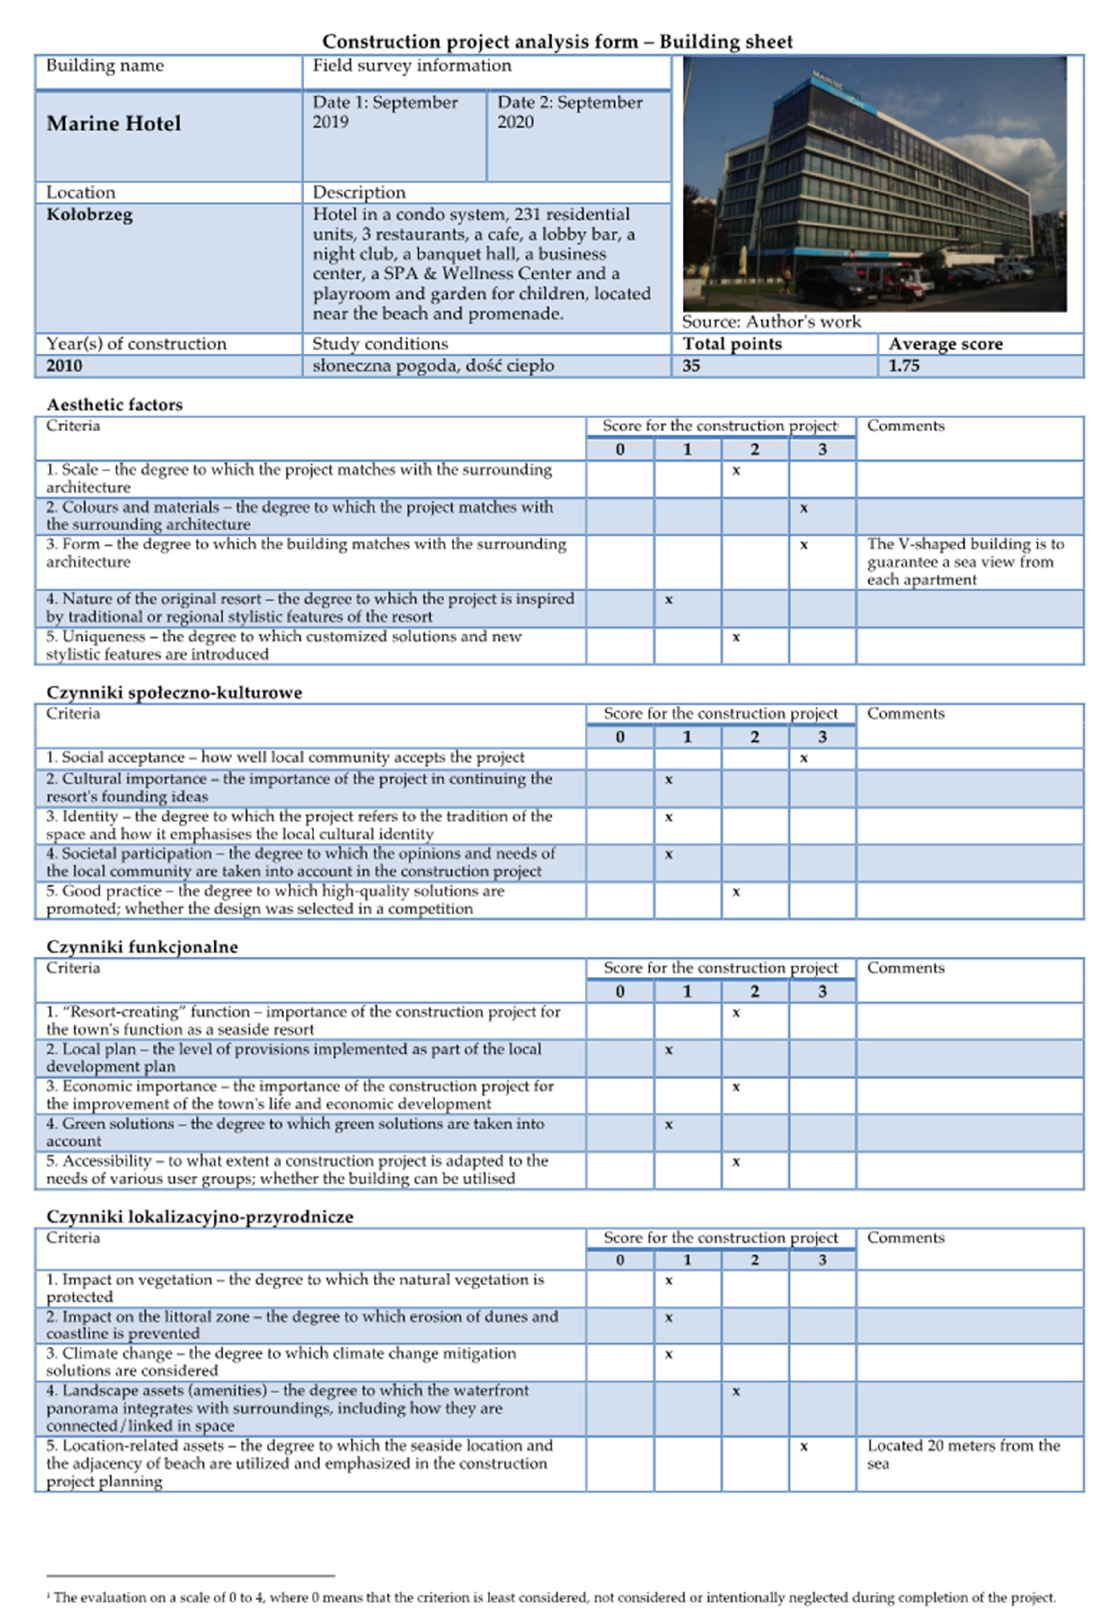
Figure A7. Marine Hotel in Kołobrzeg. Building Figure A7 . Marine Hotel in Ko ł obrzeg. Building sheet.